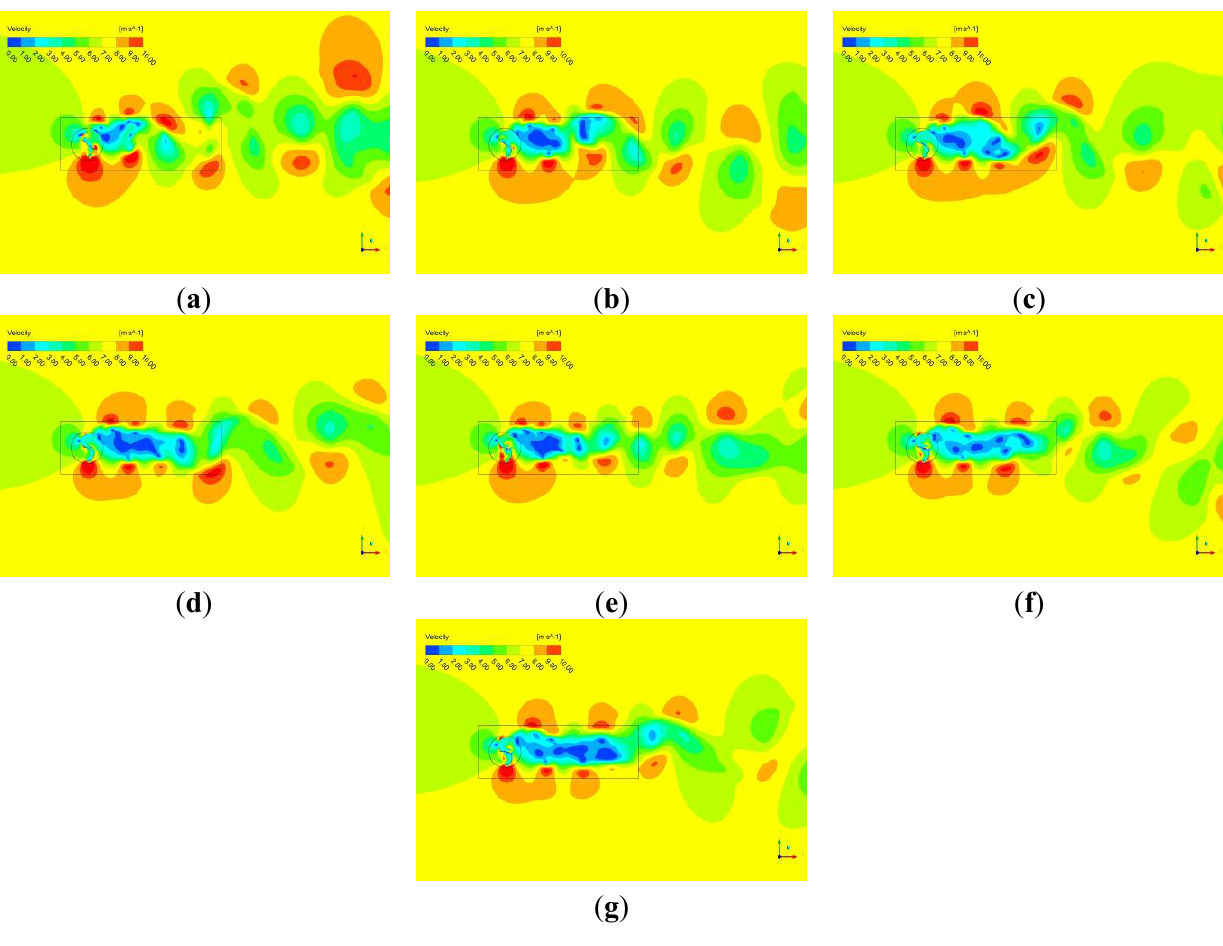
Figure 15. Velocity contours of the wake for λ = 0.8 and θ = 270°. ( a ) n = 0.5; ( b ) n = 0.75; ( c ) n = 1.0; ( d ) n = 1.5; ( e ) n = 2.0; ( f ) n = 2.5 and ( g ) n =